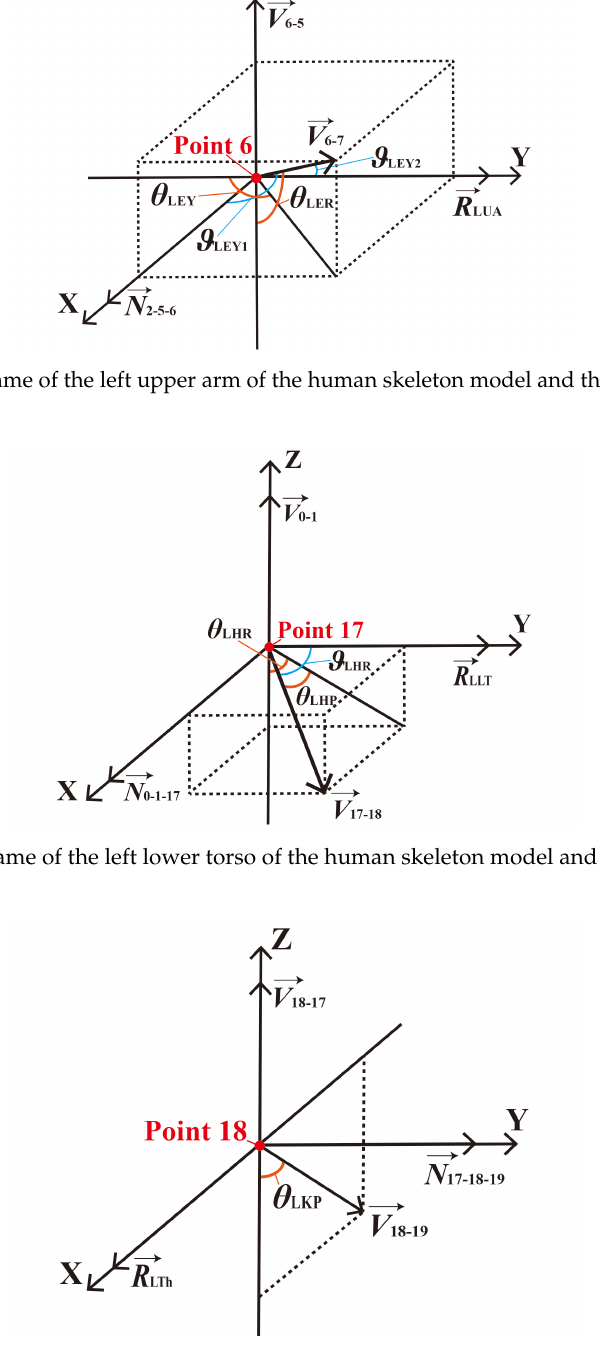
Figure 8. The link frame of the left thigh of the human skeleton model and the knee joint angle for